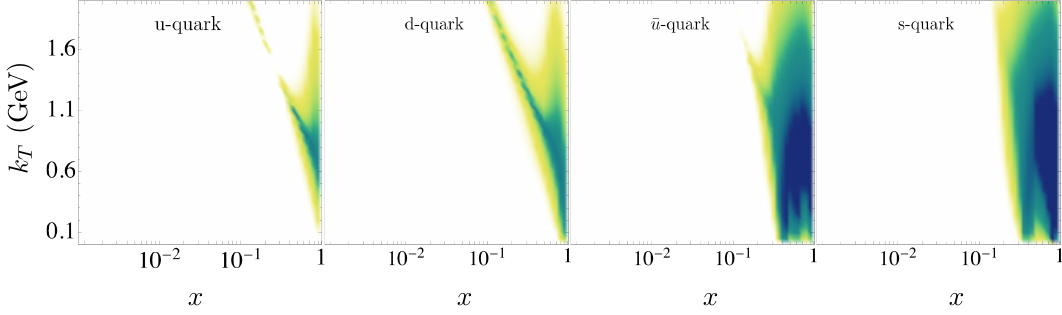
Figure 17. The function pos ( x, k T , µ ) defined in eq. (4.6) at µ = 2 (GeV) for u quark, d quark, ¯ u quark, s quark. The positivity constraint (4.5) is violated in the yellow-to-blue shaded region. applicable, given that it is based on the tree order approximation argument. Nonetheless, it is instructive to check the constraint from eq.